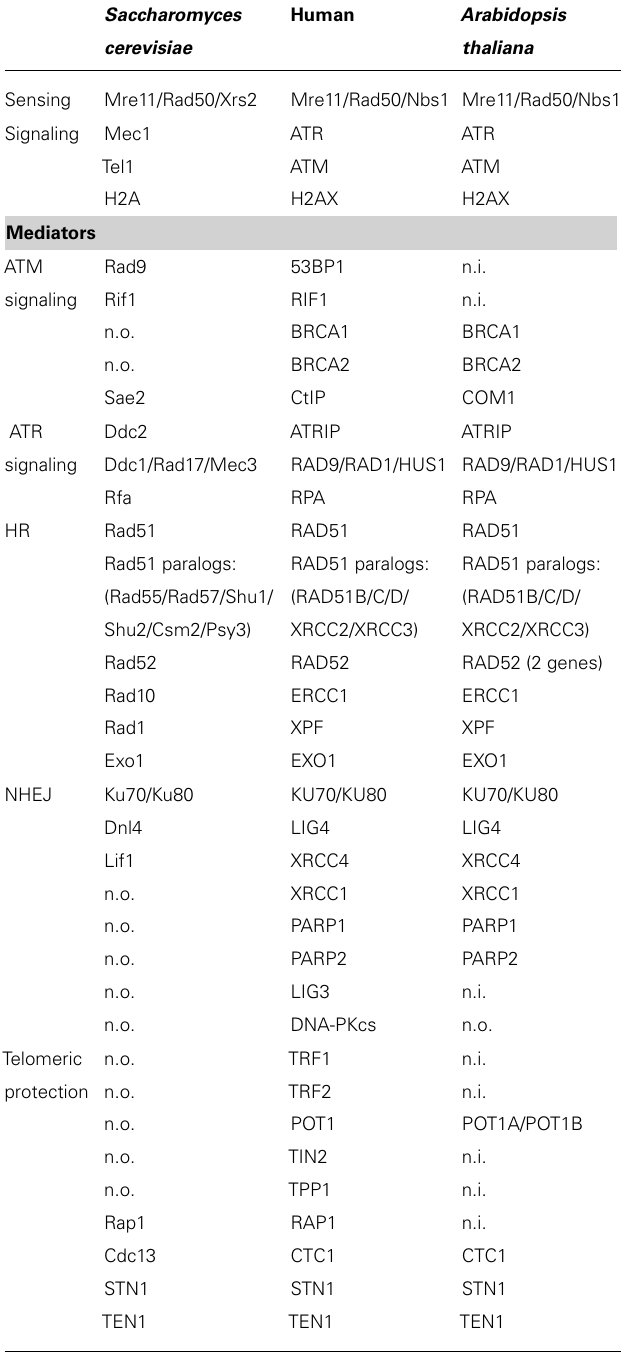
Table 1 | Major factors involved in DNA double strand break signaling and repair and telomere protection in budding yeast, human and Arabidopsis thaliana